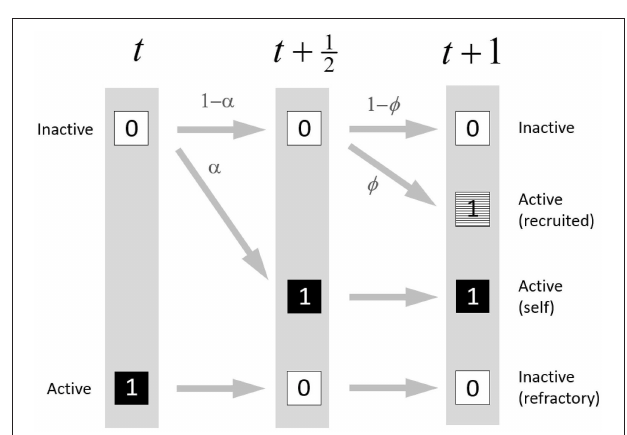
FIGURE 2 | State transition diagram for the PCA model. In the first substep, inactive sites can self-activate with probability α . In the second substep, sites that are still inactive can be recruited to activate by their nearest neighbors with probability φ which depends on the number of nearest neighbors that activated during the first substep. Sites that begin the update step as active are forced to become